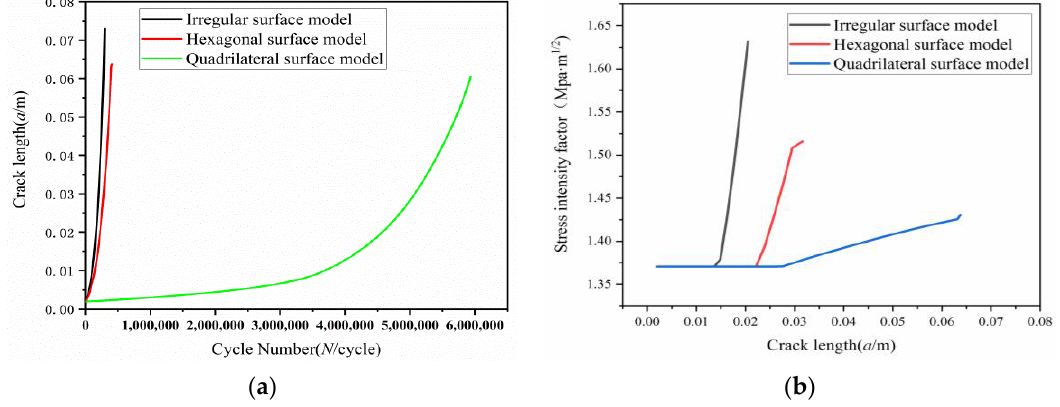
Figure 19. Comparison graph of fatigue feature parameter of three biomimetic form models: ( a ) An a-N curve of fatigue crack extension of three biomimetic form models; ( b ) relation curve of stress intensity factor and crack length.